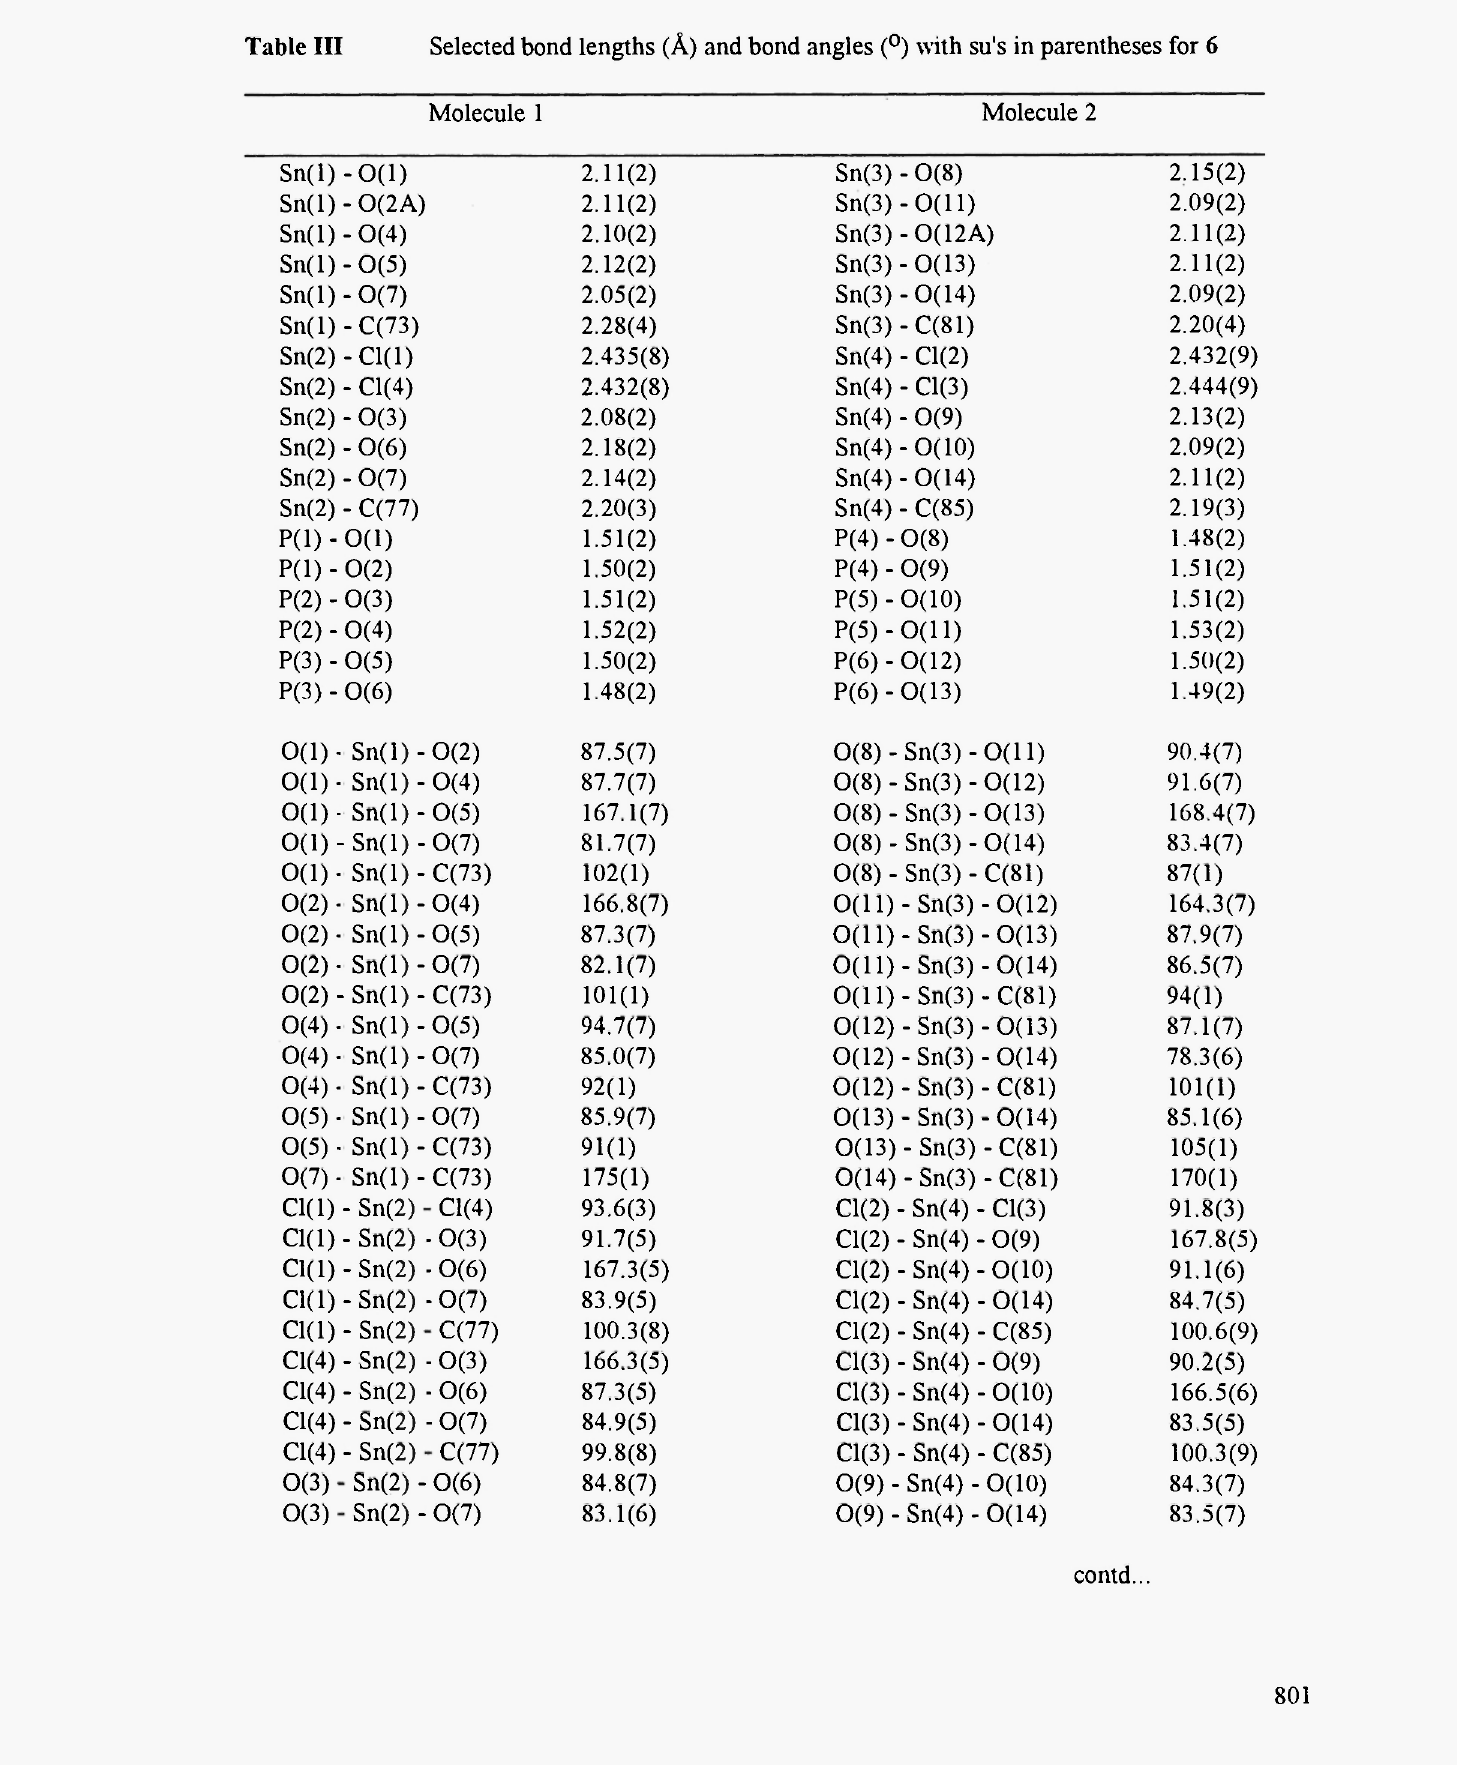
Selected bond lengths (Ä) and bond angles (°) with su's in parentheses for 6 Molecule